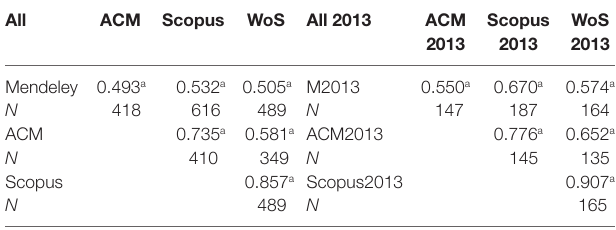
taBlE 8 | Spearman correlations between the data sources for documents retrieved by all three citation databases and included in Mendeley—all years and in 2013